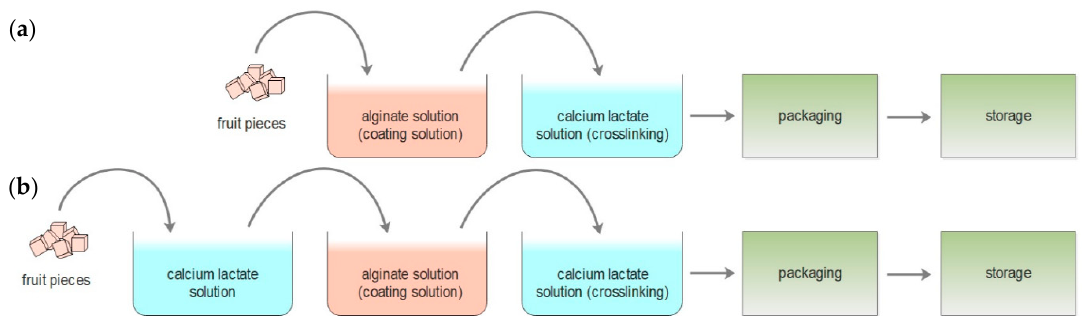
Figure 1. Schematic illustration of coating methods: ( a ) conventional dipping method to coat food products with alginate-based coatings; ( b ) novel dipping method with the incorporation of an extra immersion step into a calcium lactate solution.